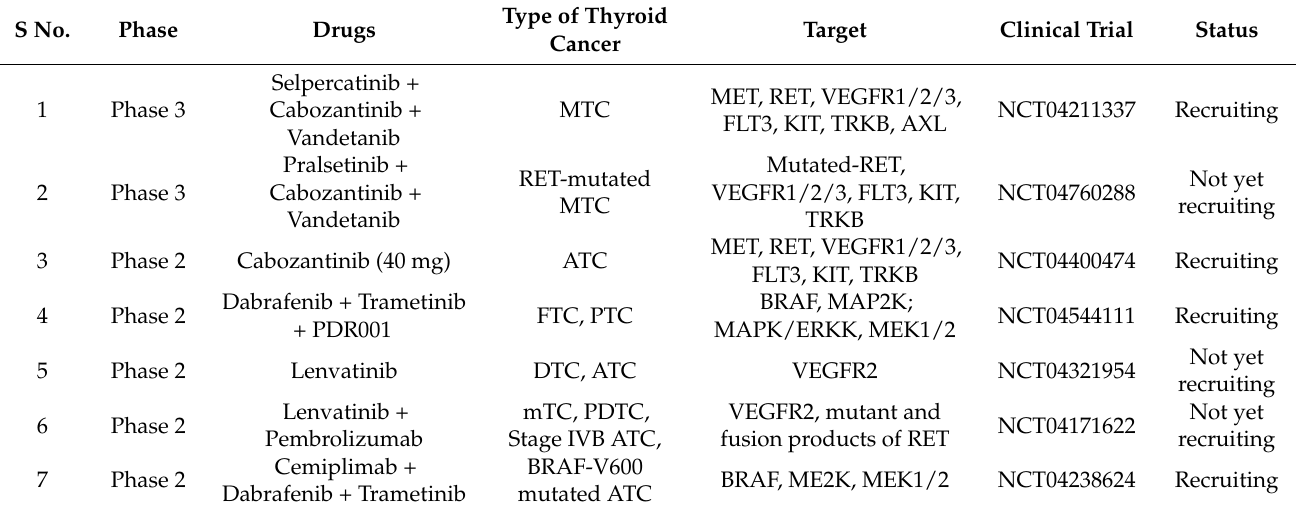
Table 1. Recent clinical trials (2020–2021) conducted in thyroid